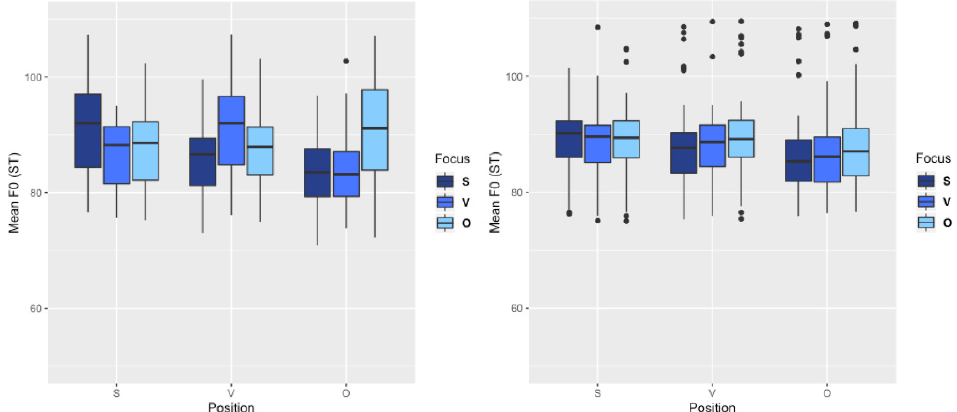
Figure 7. ( Left ) Mean f0 values (in ST) for vowels in sentences with contrastive focus on the subject (navy blue), verb (bright blue), and object (light blue) as produced in the sentence imitation task. ( Right ) Mean f0 values (in ST) for vowels in sentences with contrastive focus on the subject (navy blue), verb (bright blue), and object (light blue) as produced in the contextualized production task.